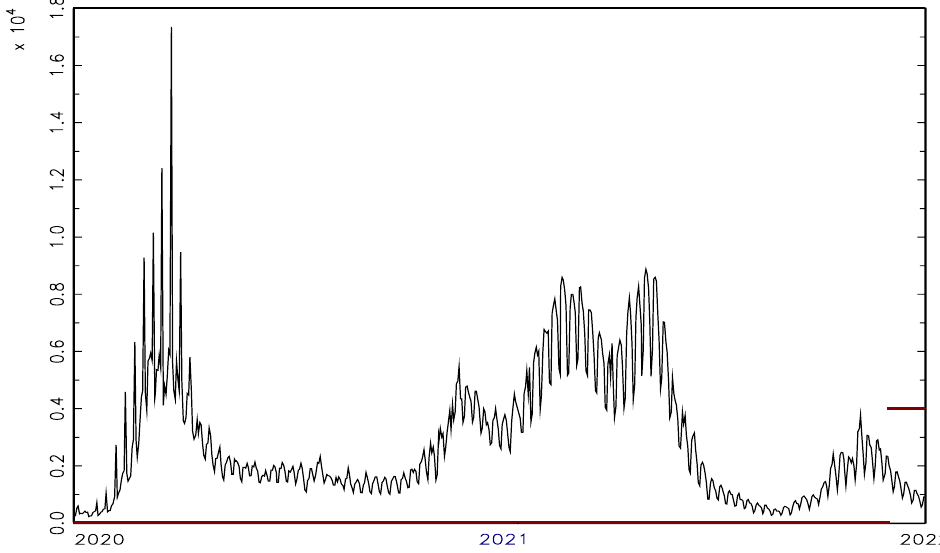
Figure 2. Filtered estimates and forecasts of new cases of infection with COVID-19 in Chile (1 April 2020 to 31 December 2021). Note: The thick red line indicates the forecasting period for this example. Table 2. AIC, AICc, BIC, and loss functions (forecasting window: last 7 days).